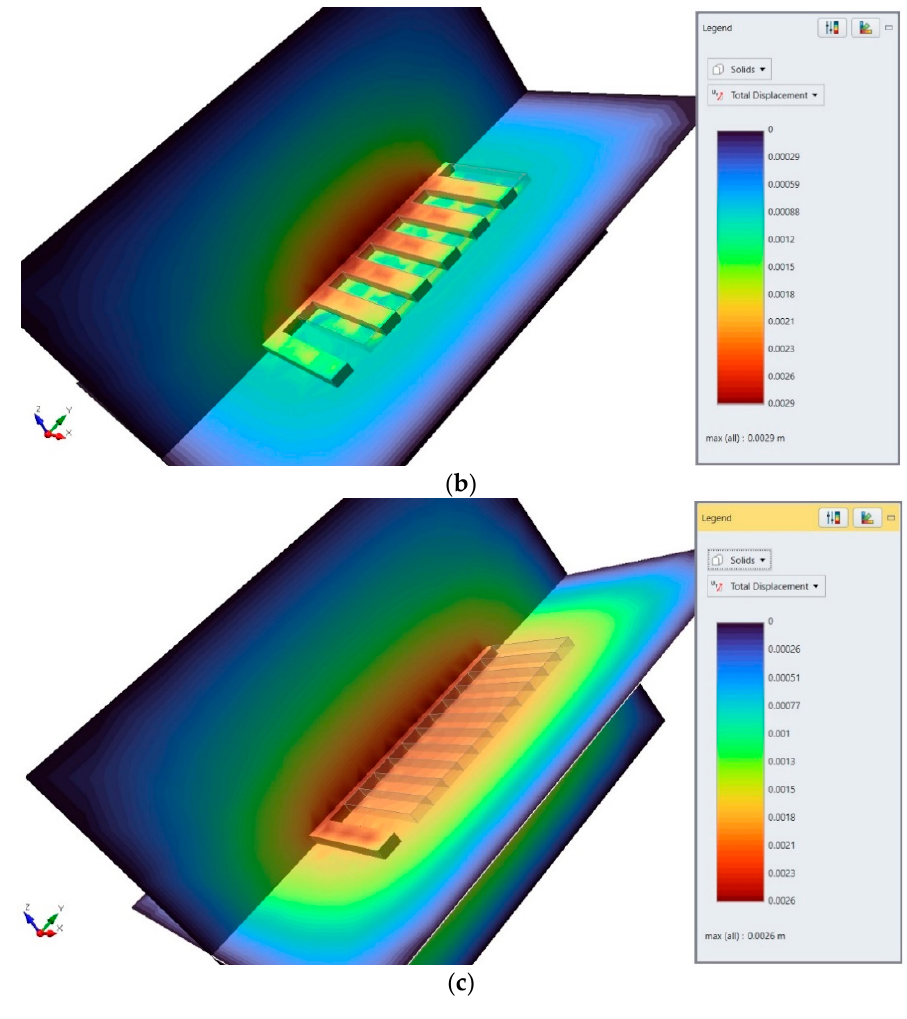
Figure 12. Total displacement for the mining field with 5% cement content in paste backfill: ( a ) second stage; ( b ) third stage; ( c ) fourth stage.